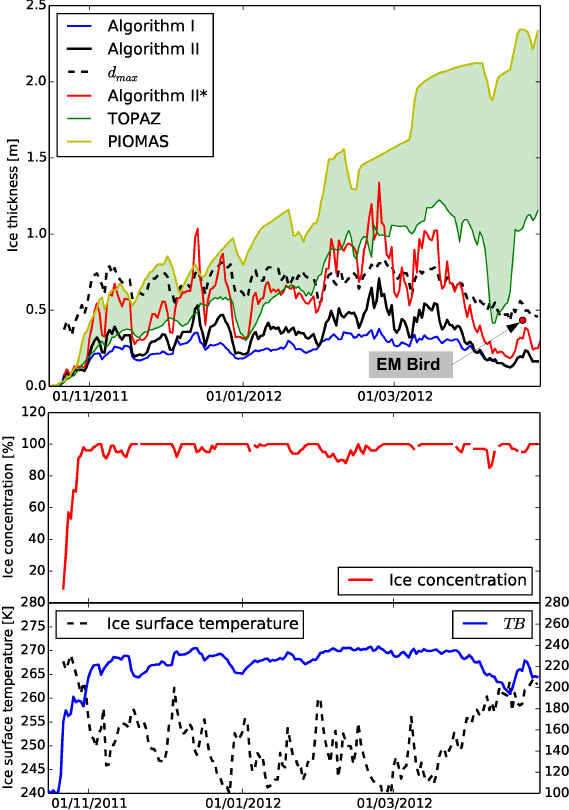
Figure 13. Time series of ice thicknesses derived from Algorithm I, II, and II*, together with d max and simulated ice thicknesses from TOPAZ and PIOMAS (upper panel) and time series of ice concen- tration (middle panel), snow (or ice in the case of bare ice) sur- face temperature and SMOS TB (lower panel) at Point 3 (74.5 ◦ N, 127.0 ◦